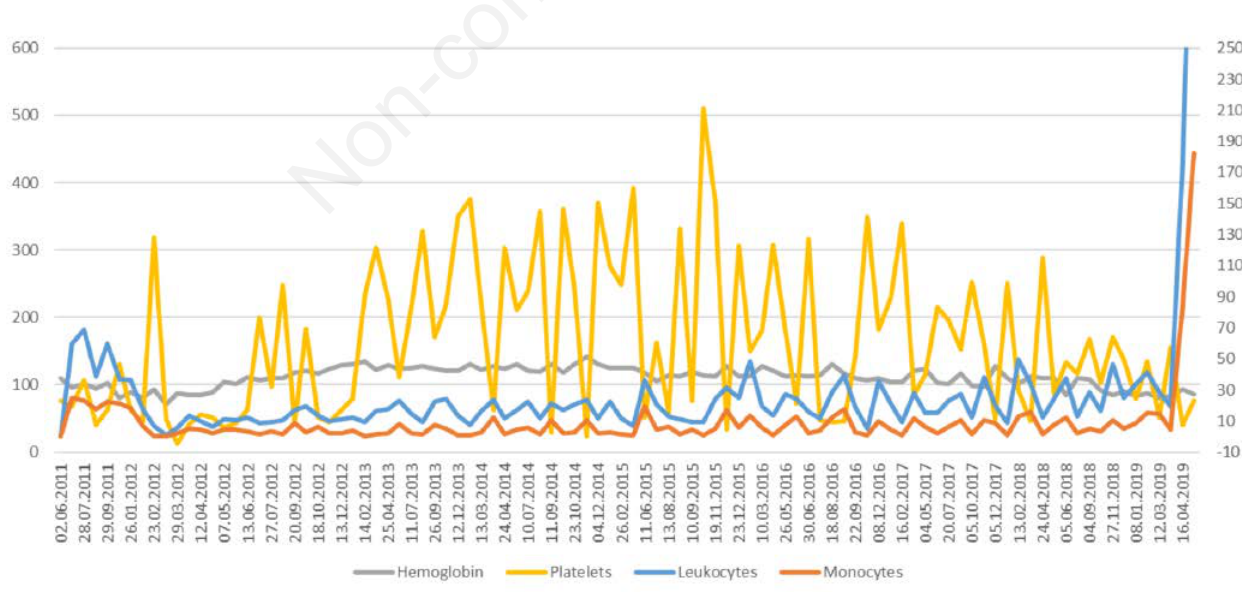
Figure 1. Correlation between platelets count and the monocyte count in response to azacitidine treatment. On the left side of the y- axis of the Chart 1 there are numbers which represent values for the hemoglobin level and the platelets count and on the right side of y-axis there are values for the monocytes and leukocytes count. There are signs of correlation between an increase of platelets count and the decrease of monocyte count in response to azacitidine